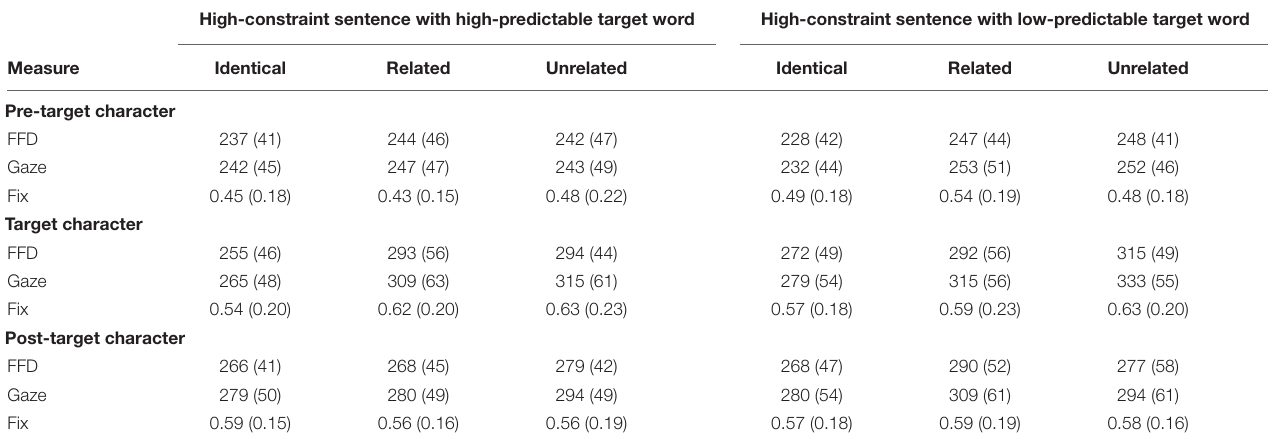
TABLE 1 | The mean and standard deviation of eye movement measures in the three regions. High-constraint sentence with high-predictable target word High-constraint sentence with low-predictable target